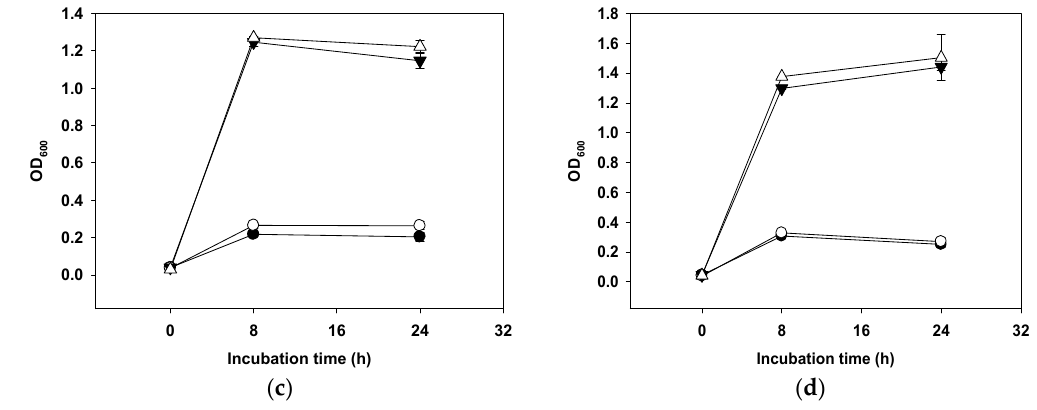
Figure 2. Growth curves for W. cibaria CMU ( a ), W. cibaria CMS1 ( b ), L. reuteri ( c ), and L. salivarius ( d ) in modified MRS medium with various carbon sources. Basal medium (glucose-free) ( ● ), basal medium with 0.3% mucin ( ○ ), basal medium with 1.0% glucose ( ▼ ), and basal medium with 0.3% mucin and 1.0% glucose ( △ ).